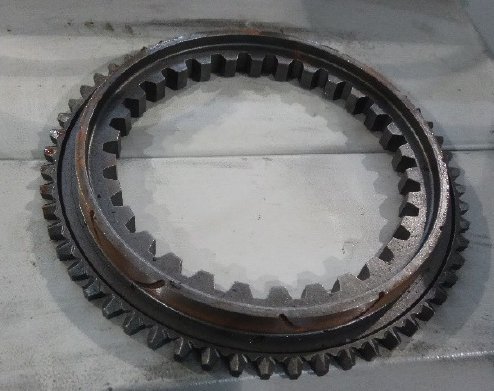
Figure 12. The workpiece of synchronizer cone.